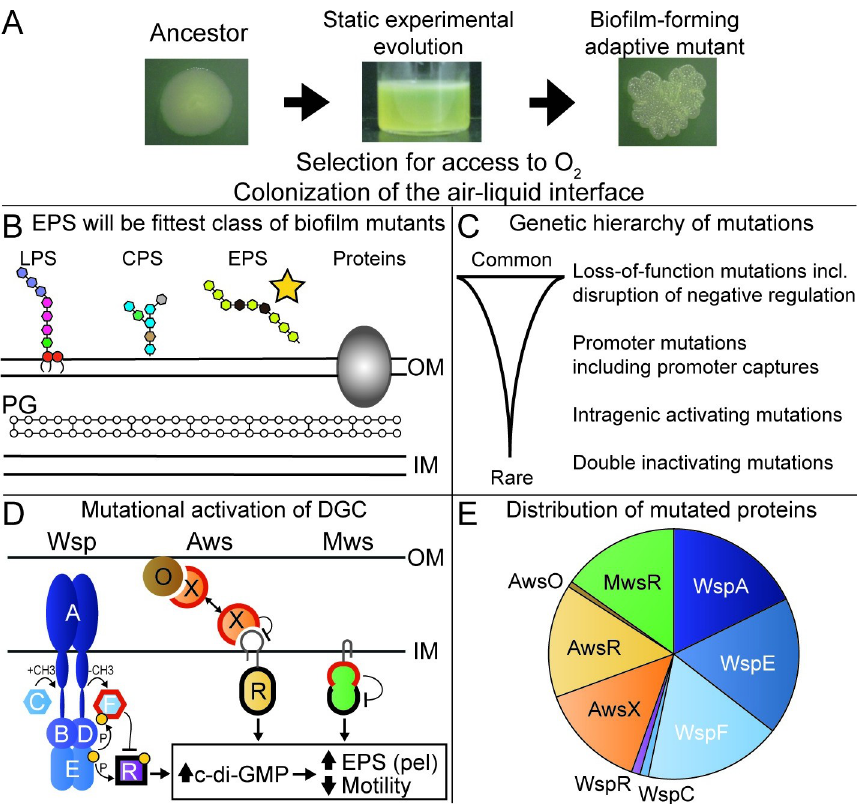
Fig 1. Evolutionary predictions and outcomes of experimental evolution for Pseudomonas protegens Pf-5. ( A ) Growth under static conditions when oxygen is limiting to growth is expected to result in selection for colonization of the air-liquid interface by increased cell-cell adhesion and surface attachment. Pictured is a wrinkly spreader mutant of Pseudomonas fluorescens SBW25. ( B ) The cell wall of Pf-5 has several components that could possibly be used to promote cell-cell adhesion and surface attachment, including lipopolysaccharides (LPS), capsular polysaccharides (CPSs), exopolysaccharides (EPSs), adhesive proteins, and incomplete cleavage of the peptidoglycan (PG) layer. ( C ) The types of adaptive mutations expected are, in decreasing frequency, loss-of-function mutations, promoter mutations, intragenic activating mutations, and double inactivating mutations [28]. ( D ) Mutational activation of di- guanylate cyclases (DGCs–outlined in black; WspR, AwsR, and MwsR) by loss-of-function mutations in negative regulators (outlined in red; WspF, AwsX, and MwsR) will lead to increased c-di-GMP production, resulting in overexpression of an EPS and reduced motility. In SBW25, these occur in three main pathways, Wsp, Aws, and Mws. ( E ) Predicted fraction of WS mutations for genes in the main three pathways. Knowledge of the molecular networks allowed for the formulation of a mathematical model that accurately predicted the relative rates of use of the common three pathways (Wsp, Aws, and Mws) [26] and rates for proteins in each pathway. The assumption that the molecular functions of these networks are conserved in Pf-5 allows prediction of the rates of pathways and proteins.